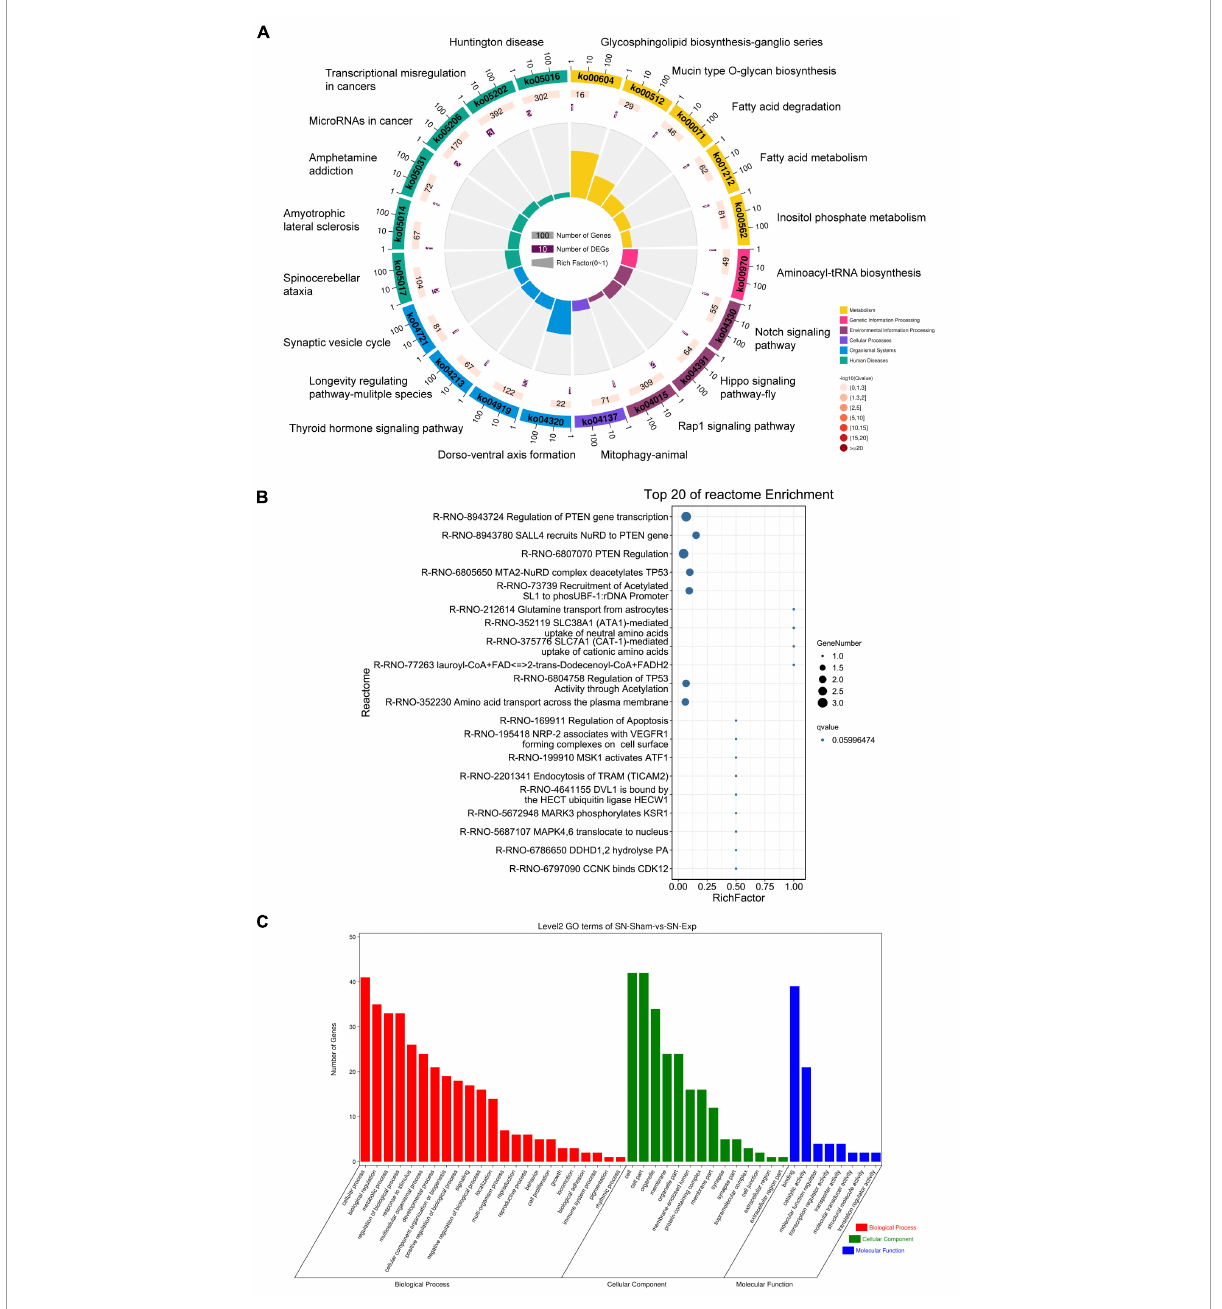
FIGURE6 Annotation of host genes of differentially expressed circular RNAs after rat peripheral axon injury. Enriched (A) KEGG pathways, (B) reactome pathways, and (C) GO terms.